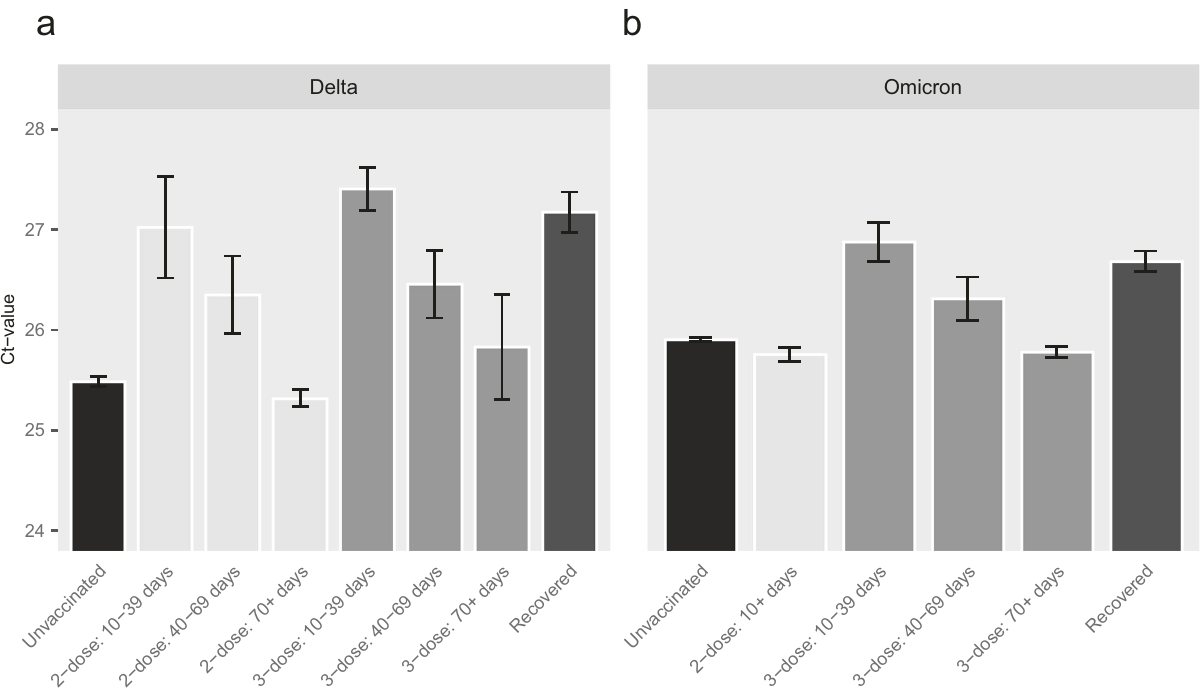
Fig. 1 | Ct values of the gene N. Adjusted Ct values of different vaccination statuses, measuredbyfour laboratories, forthe Delta ( a , n =101,897 independent samples), and Omicron ( b , n =181,634 independent samples) variants. Means were obtained from the weighted sum of age, sex and calendar time, and the